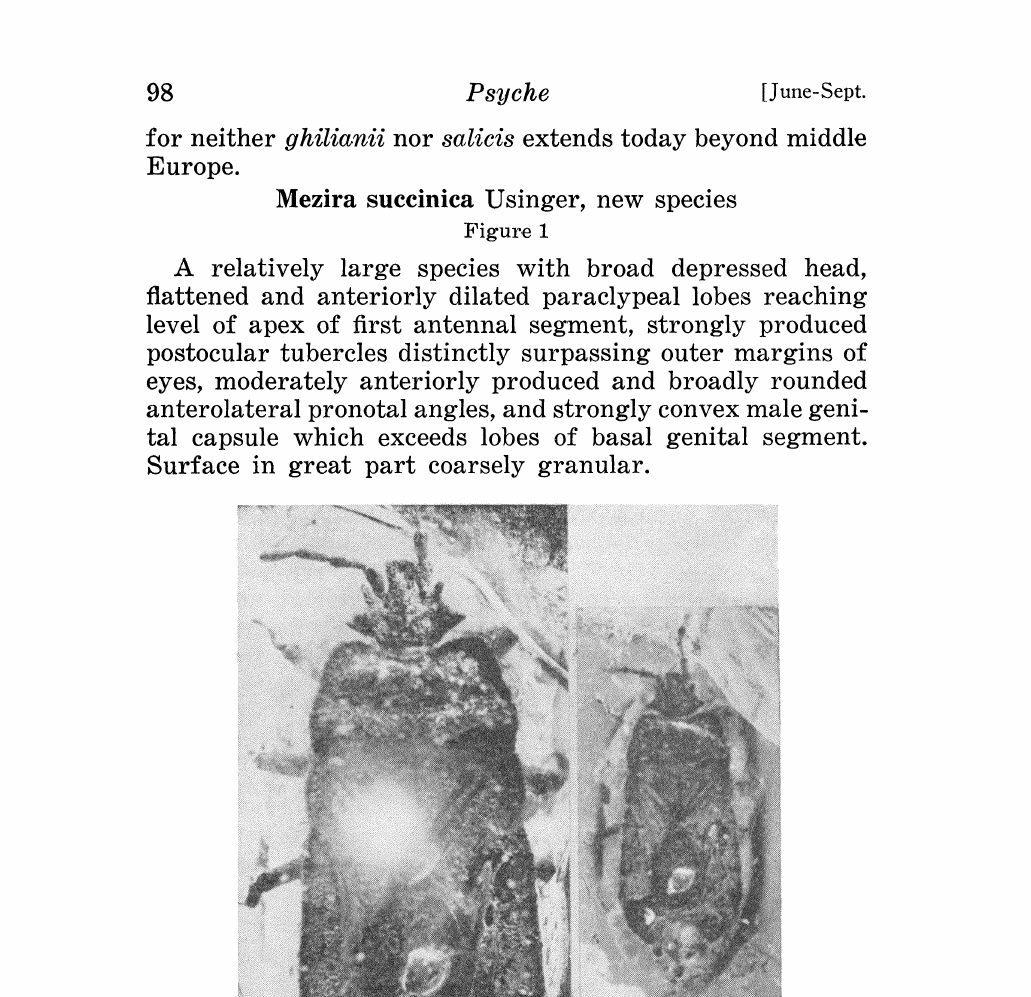
Figure 1. Mezira succinica n.sp. Photograph of holotype. A, x 8; B, x4.